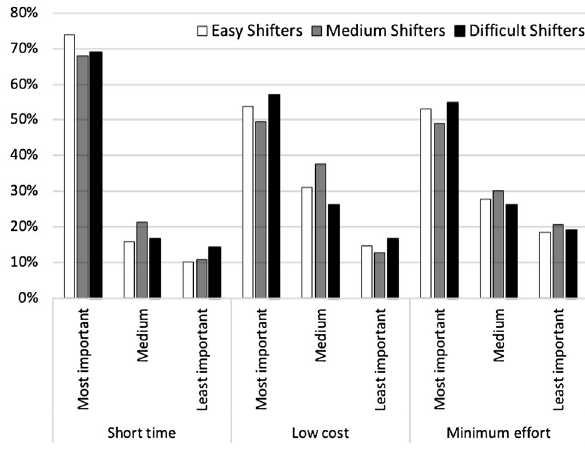
Fig. 6 Respondents’ station–campus feeder priorities (%)